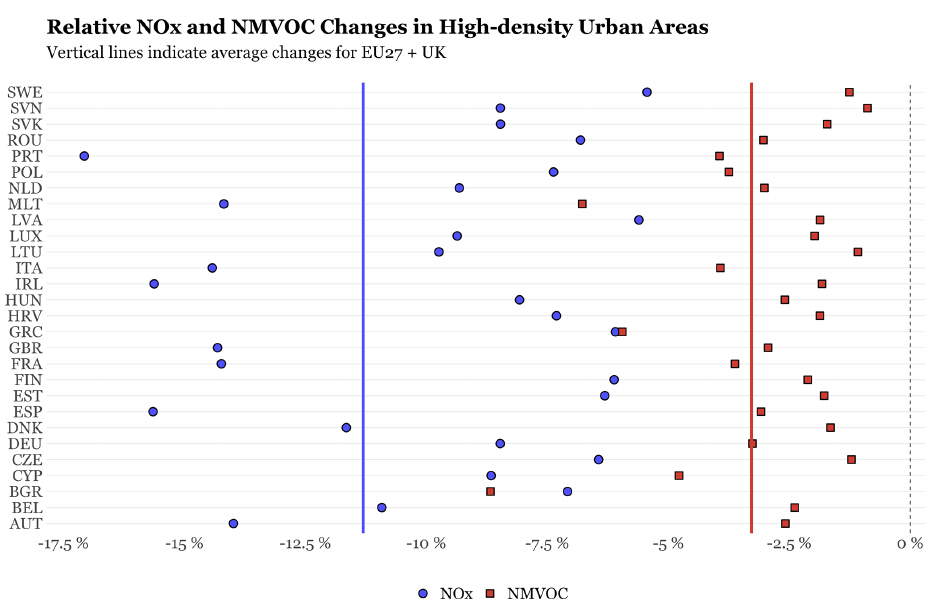
Figure 13. Relative NO x and NMVOC emission declines [%] per country occurring in high-density urban areas between 1 January and 31 December 2020. High-density urban areas were defined according to the Global Human Settlement Layer (GHSL) project (Pesaresi et al., 2019). The solid blue and red lines represent the average NO x and NMVOC emission declines at the EU27 + UK